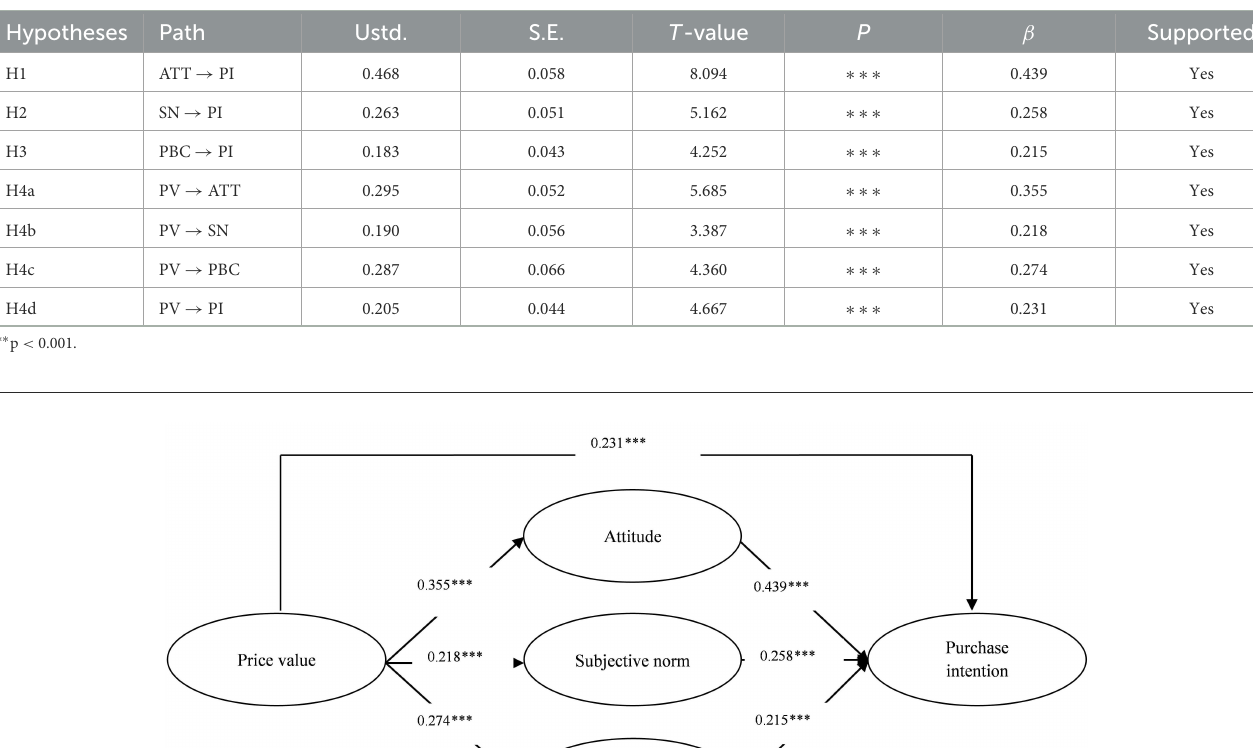
TABLE 5 Summary of hypotheses test.